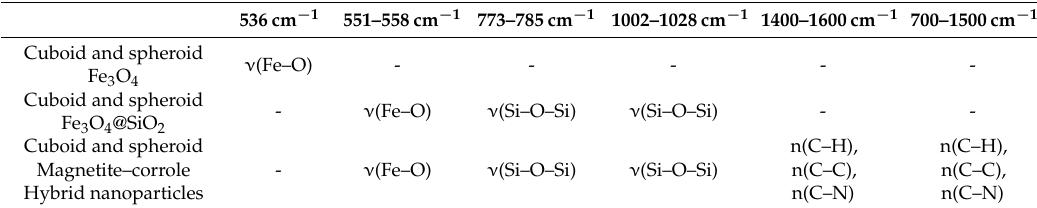
Table 1. FTIR/ATR vibrational bands and respective assignments for all the prepared nanoparticles and hybrids.